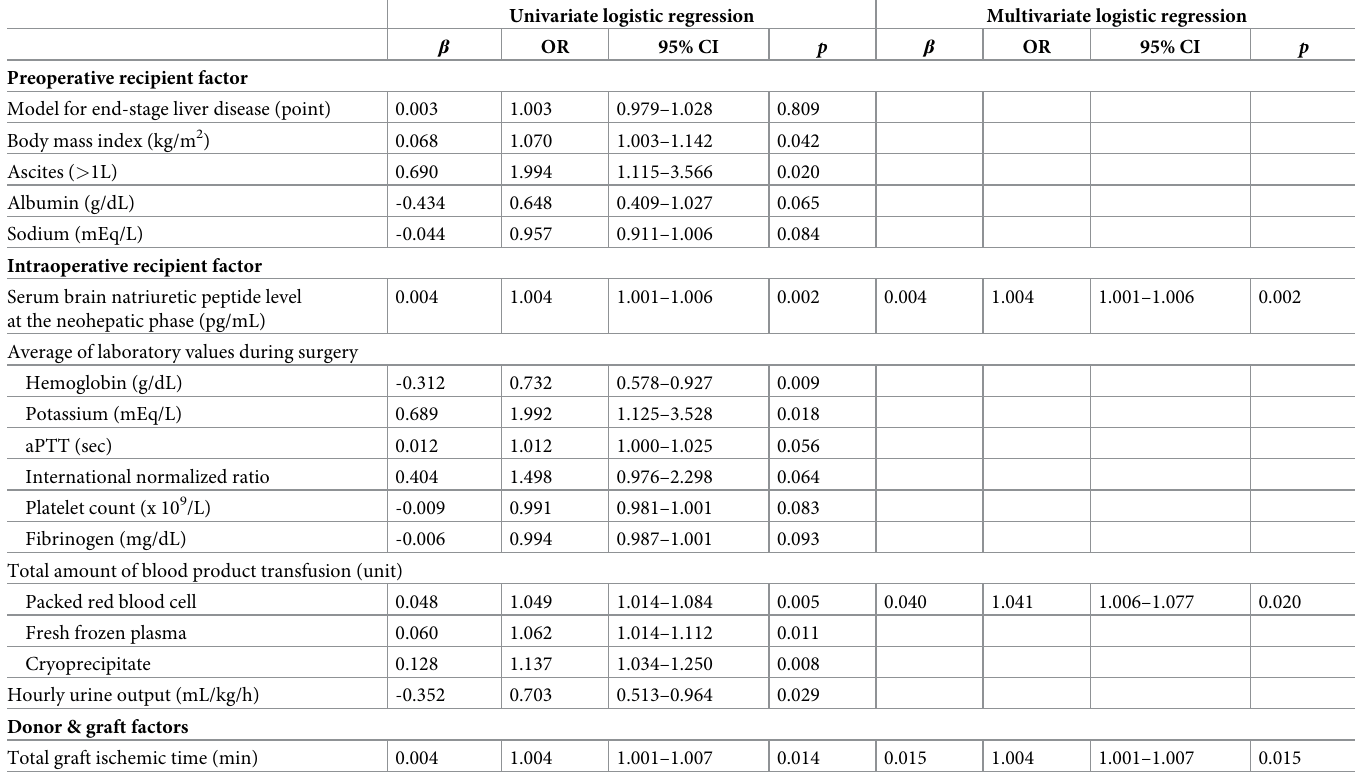
Table 7. Associations between perioperative factors and early acute kidney injury development after living donor liver transplantation. Univariate logistic